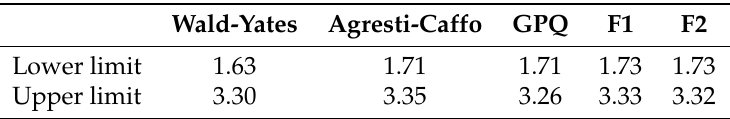
Table 4. 95% confidence intervals for the number needed to expose for the depression and insomnia